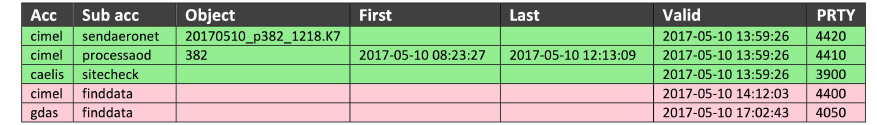
Figure 5. Example of CÆLIS task stack. Ordering is related to the next task to be executed. Green indicates tasks that can be already selected to be executed. Red indicates tasks to be executed in the future (when “valid” time arrives). The example is captured at 14:00UTC on 10 May